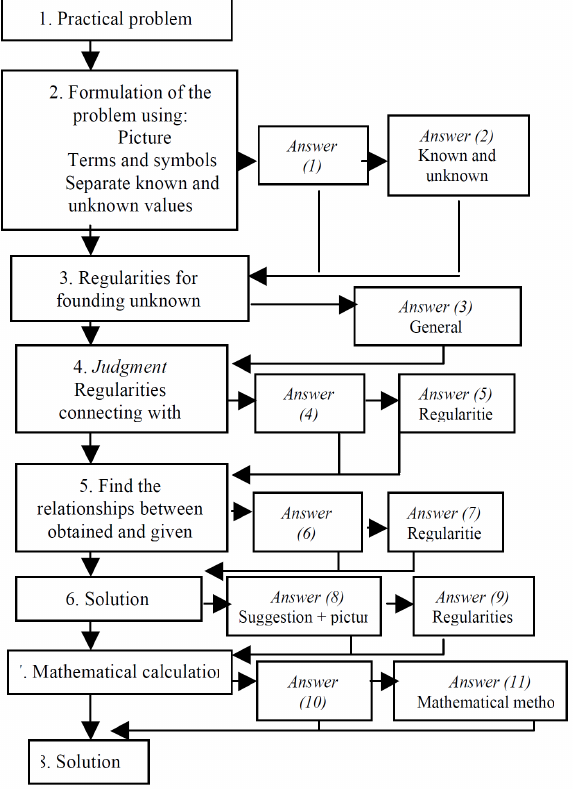
Figure 12. Framework for organization of practical problem solving in mathematics (didactical steps) mately 60% of respondents consider that mathemati- calthinking helps to solve real professional